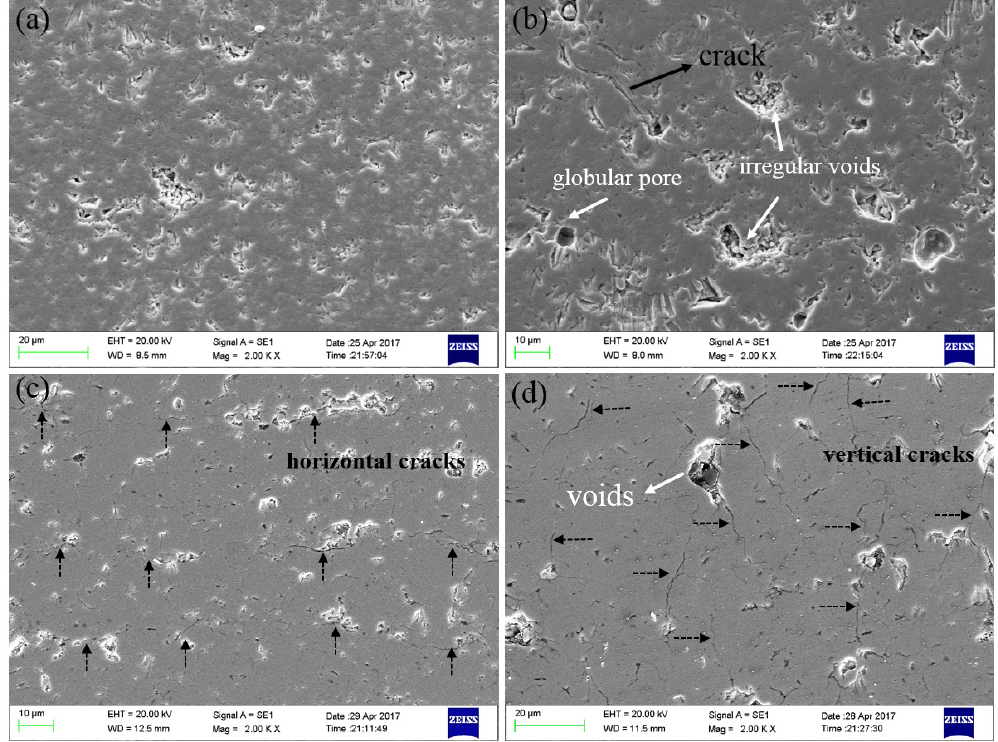
Figure 5. Typical microstructures of the YSZ coating: ( a ) As ‐ sprayed, 15–25 μ m; ( b ) as ‐ sprayed, 45–60 μ m; ( c ) after heat pre ‐ treatment, 15–25 μ m; and ( d ) after heat pre ‐ treatment, 45–60 μ m.